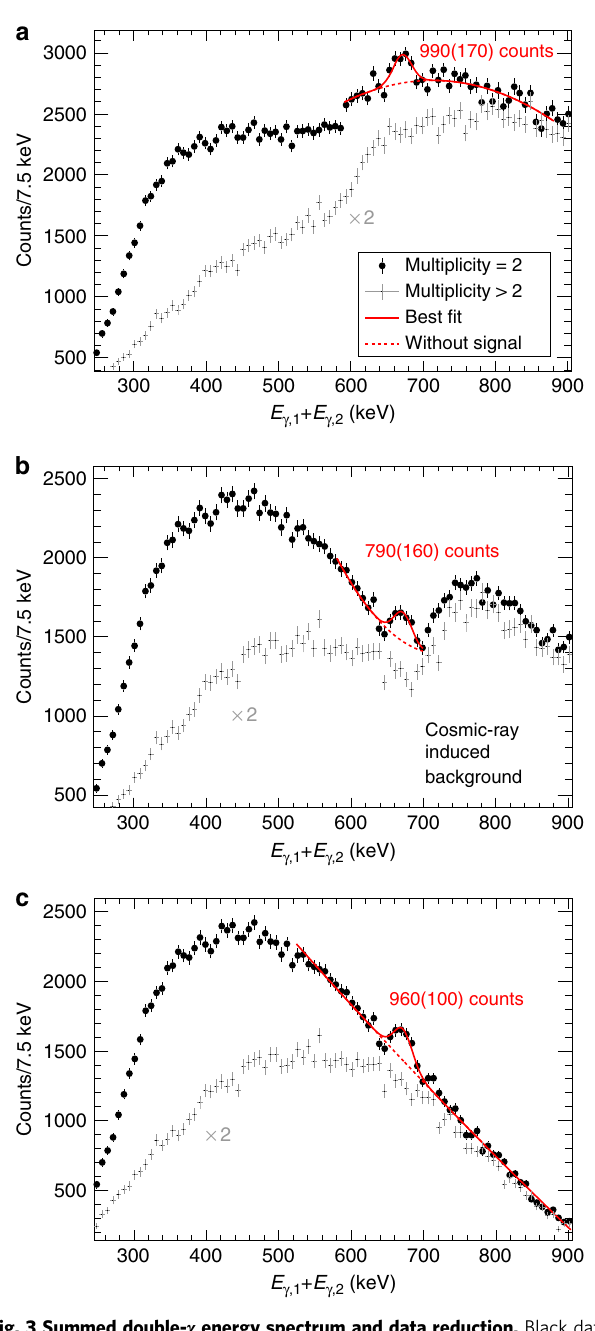
Fig. 3 Summed double- γ energy spectrum and data reduction. Black data points show the summed energy of two coincident photons detected in the CeBr 3 detectors for events with a multiplicity of two. Grey data points show the sum energy spectrum when the multiplicity is larger than two, which mainly correspond to the background induced by cosmic ray showers. We also show the fi t to the data of a quadratic background as a dashed red line and the fi t of the background plus a Gaussian peak as a solid red line. a Raw data before any conditions. b Reduced data with the condition that the energy difference between two γ rays is j E γ ; 1 (cid:2) E γ ; 2 j < 300 keV. c Final data with the additional condition that j E γ ; 1 (cid:2) E γ ; 2 j < 960 (cid:2) ð E γ ; 1 þ E γ ; 2 Þ keV to remove the cosmic-ray induced background. The error bars represent the one standard-deviation statistical